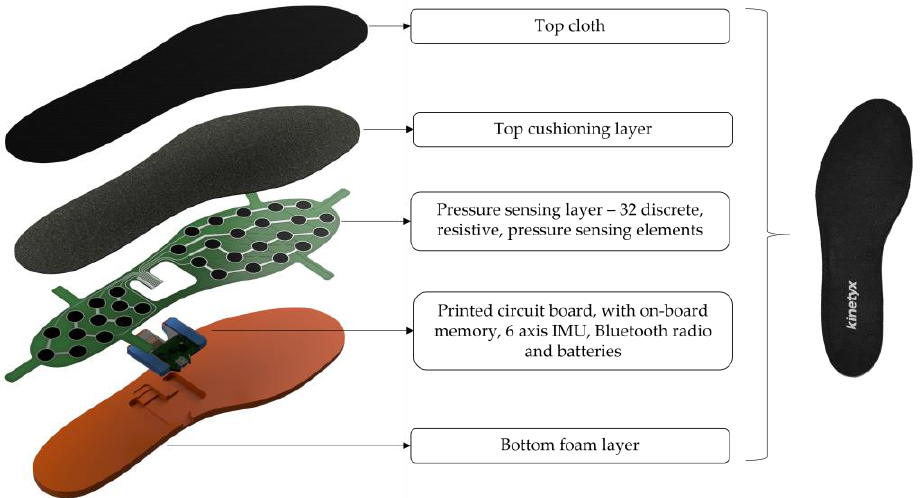
Figure 1. Expanded view of the Kinetyx SI System displaying the main components of the system contained within the fully integrated design, including a pressure-sensing layer (green) which contains 32 resistive pressure-sensing elements distributed across the rearfoot and forefoot regions.